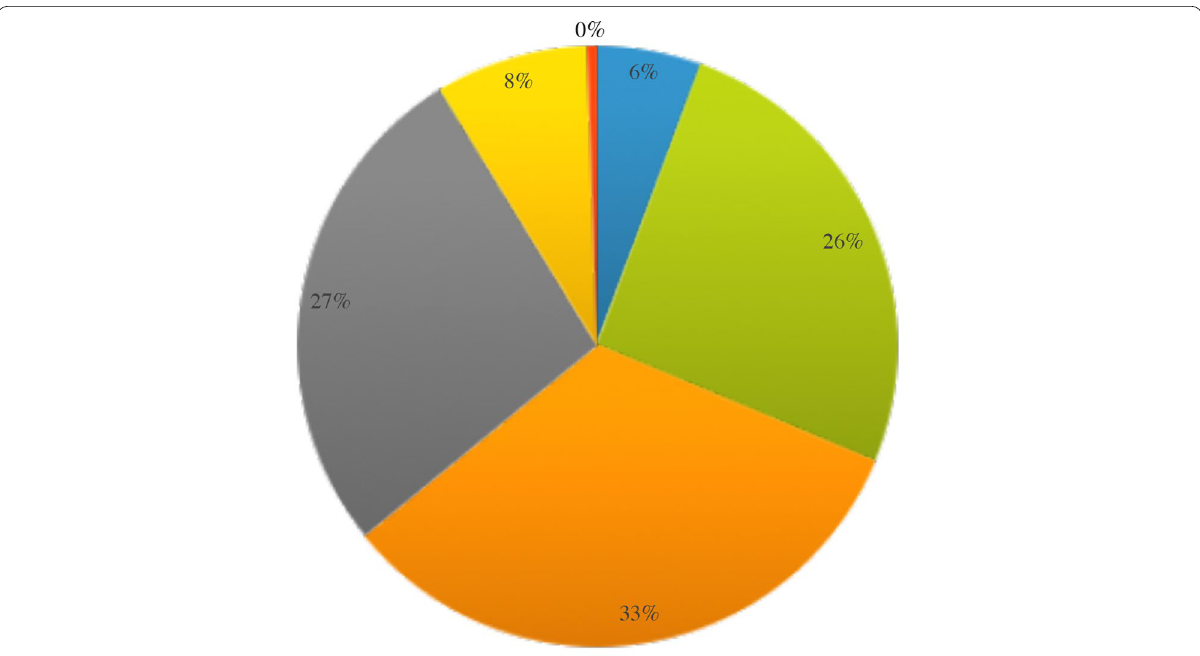
Fig. 8 Classification of peptidases, according to the MEROPS database, encoded within the Naganishia randhawae CBS 16859 genome (Rawlings et al.